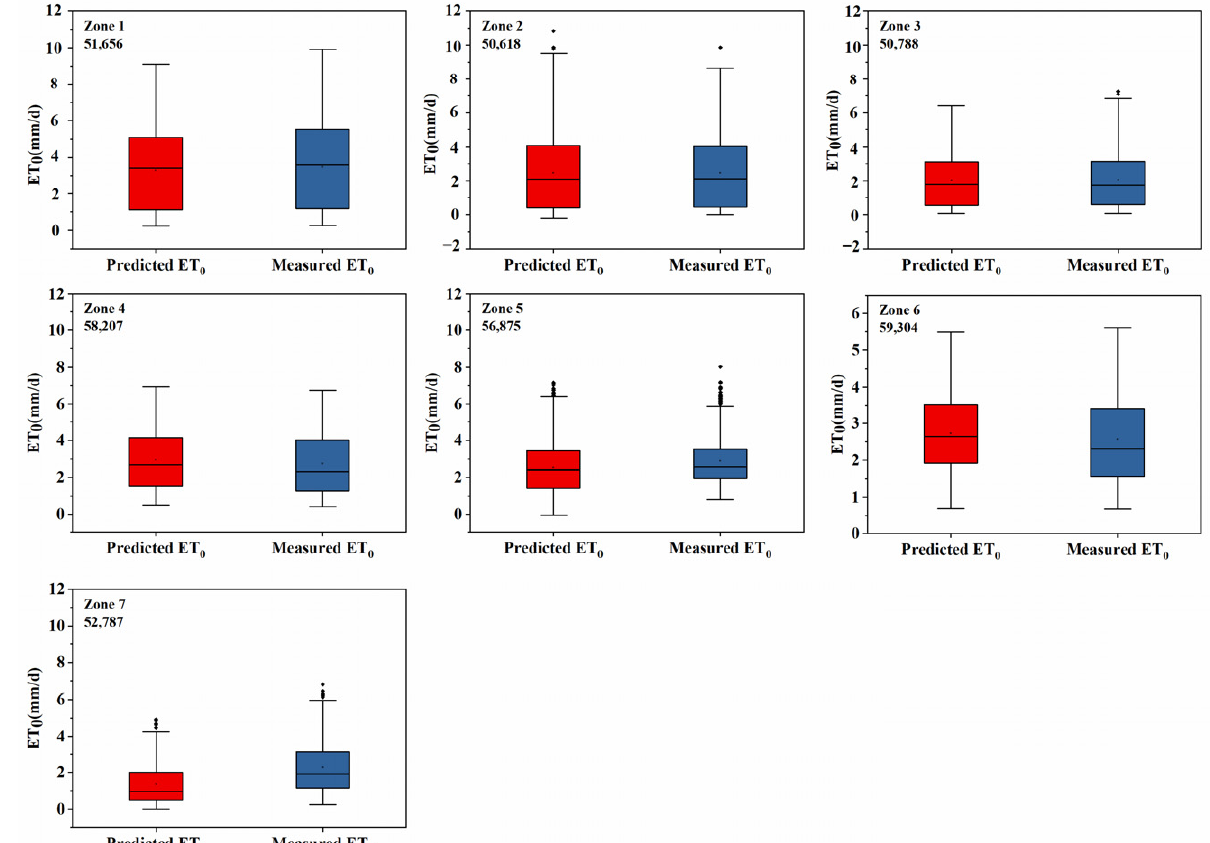
Figure 7. The box diagram of CLDAS and FAO56 PM values of ET 0 in different climates.